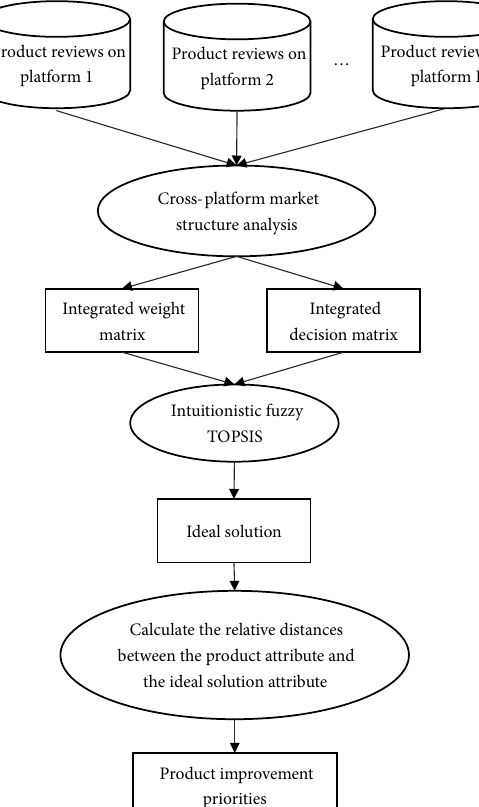
Figure 2. The process to generate the product-improvement